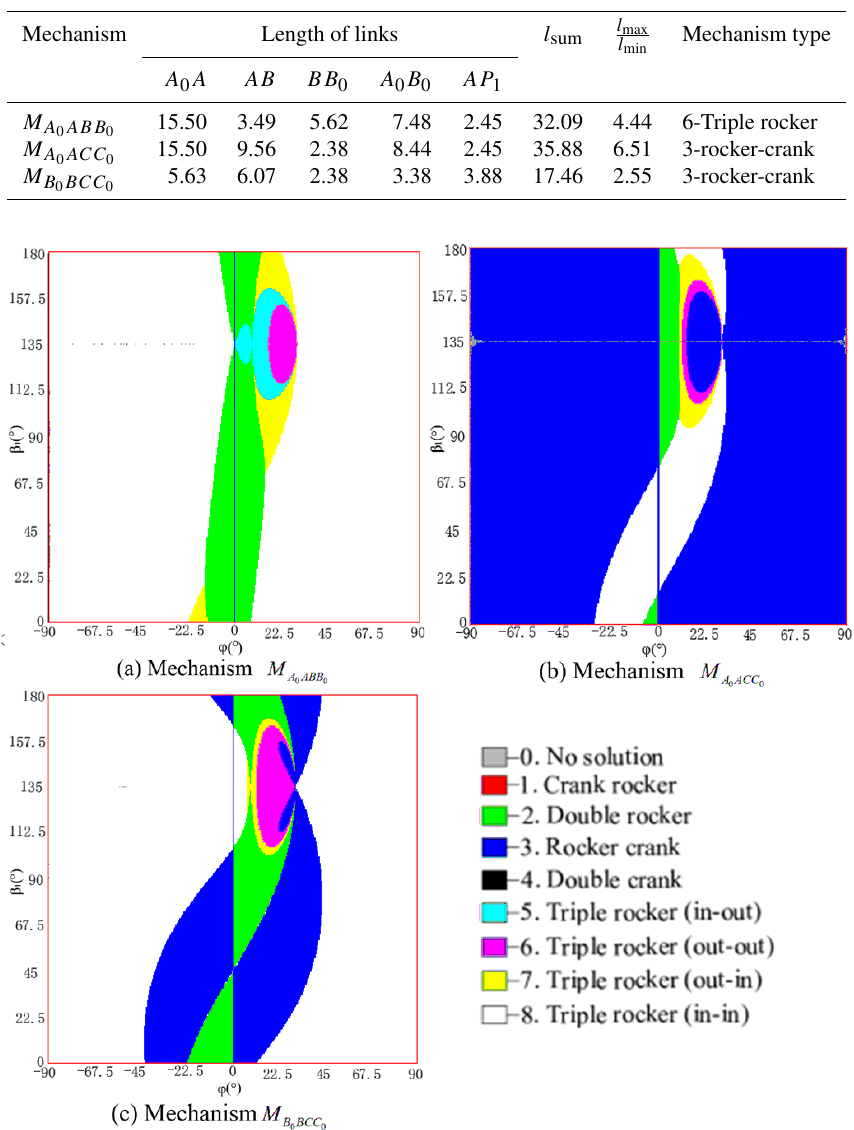
Table 1. Mechanism parameters.